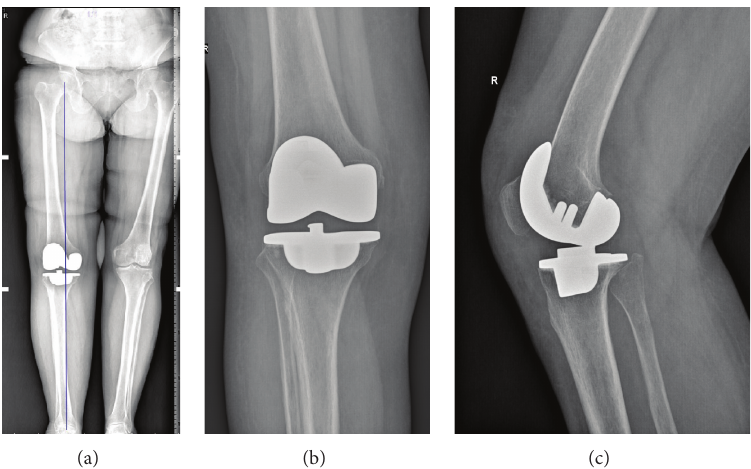
Figure 1: Long standing anteroposterior X-ray showing adequate anatomic alignment (a) and anteroposterior and lateral nonweight bearing radiographs ((b) and (c),